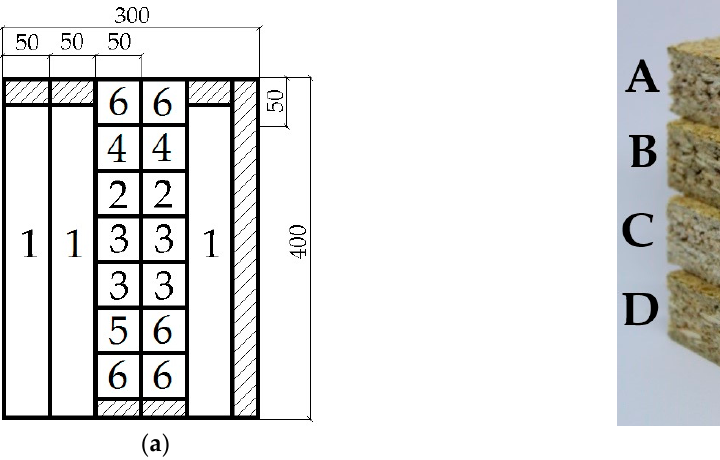
Figure 3. Scheme of samples preparation from the PB ( a ): 1—MOR and MOE by 3-point bending test [23], 2—TS and WA after 2 and 24 h [24,25], 3—IB [26] and density [27], 4—decay resistance to the fungus Serpula lacrymans [28], 5—mould resistance [29], 6—spare samples; ( b ) Display of PB-samples 50 mm × 50 mm × 16 mm with different amount of particles from recycled spruce pallets (RSP) w/w (%): (A) C = 0%, (B) 20RSP = 20%, (C) 50RSP = 50%, and (D) 100RSP = 100%.